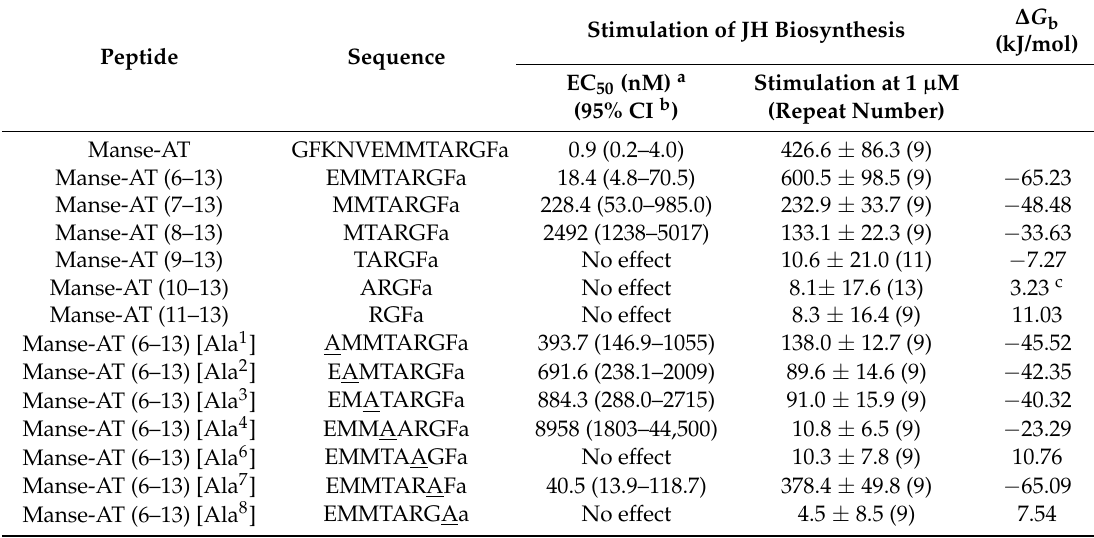
Table 1. Structures, stimulation of JH biosynthesis and free energy of binding of Manse-AT and analogs.